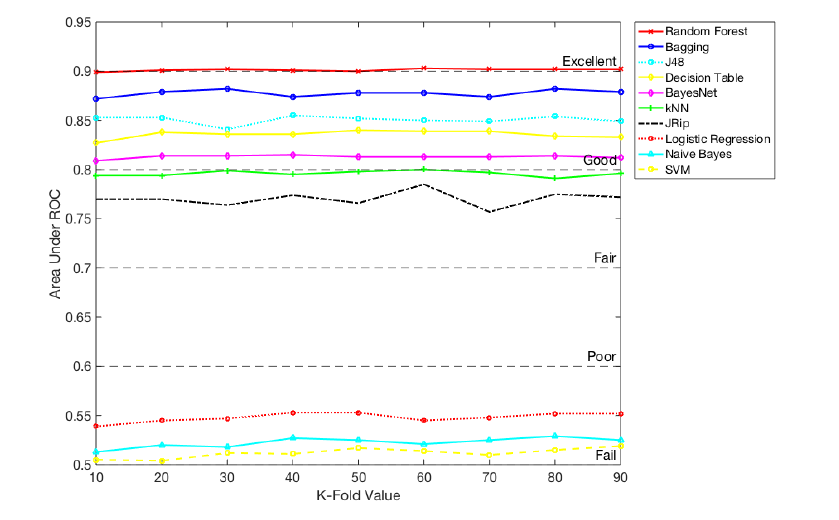
Figure 3. The area under the ROC Curve for all classifiers: excellent (0.9–1), good (0.8–0.9), fair (0.7–0.8), poor (0.6–0.7) and fail